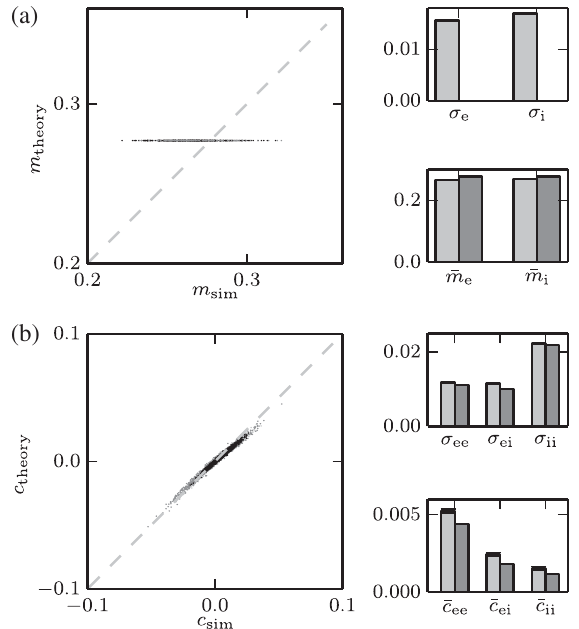
FIG. 5. Modified Lyapunov method. Solution of the individual pairwise covariances by the projection method applied to the continuous Lyapunovequationincomparisontosimulationresults. (a) Mean activities predicted by the approximation that neglects cross-correlations (black is for excitatory; gray is for inhibitory). Lower inset: Mean activity averaged over excitatory and inhibitory neurons (light gray is for simulation; darker gray is for theory). Black error bars show the standard error of the mean obtained from 20 simulations (barely visible, approximately at line width). Upper inset: Width of distribution of mean activities. (b) Theoretical distribution of covariances (29) with D chosen according to Eq. (30) [same approximation as in (a) for m and S , i.e., neglecting cross-correlations in the input to each neuron). Lower inset: Mean covariances averaged over excitatory-excitatory, excitatory- inhibitory, and over inhibitory-inhibitory neuron pairs (light gray is for simulation; darker gray is for theory). Error bars show the standard error of the mean obtained from 20 simulations. Upper inset: Width of the distributions of covariances. Other parameters and the display are the same as in Fig.